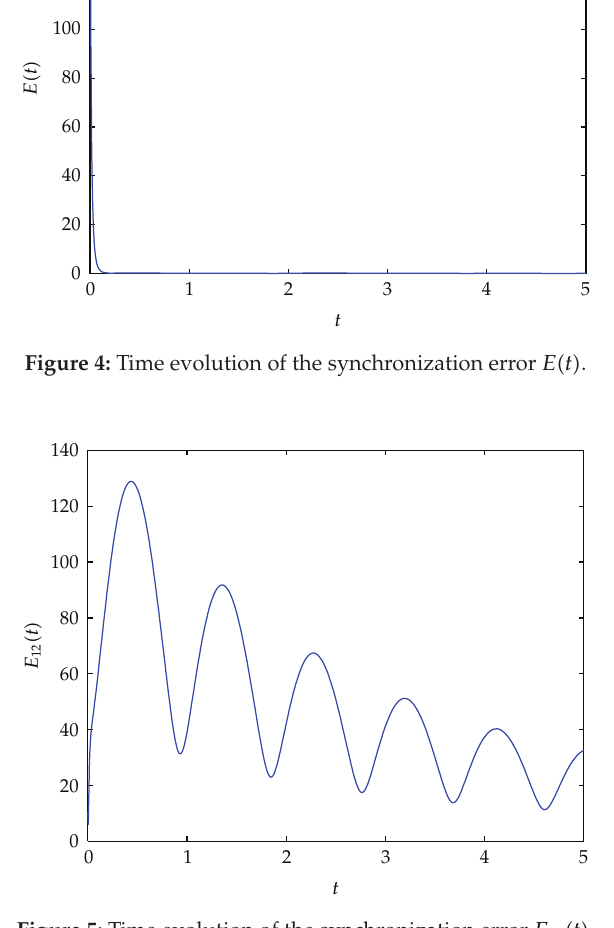
Figure 5: Time evolution of the synchronization error E 12 (cid:6) t (cid:7)